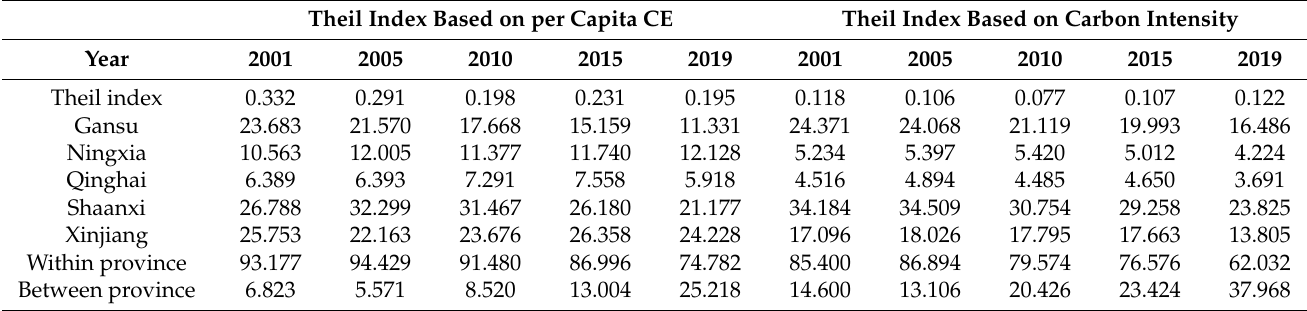
Table 5. Difference contribution rate of CE in northwest China from 2001 to 2019.